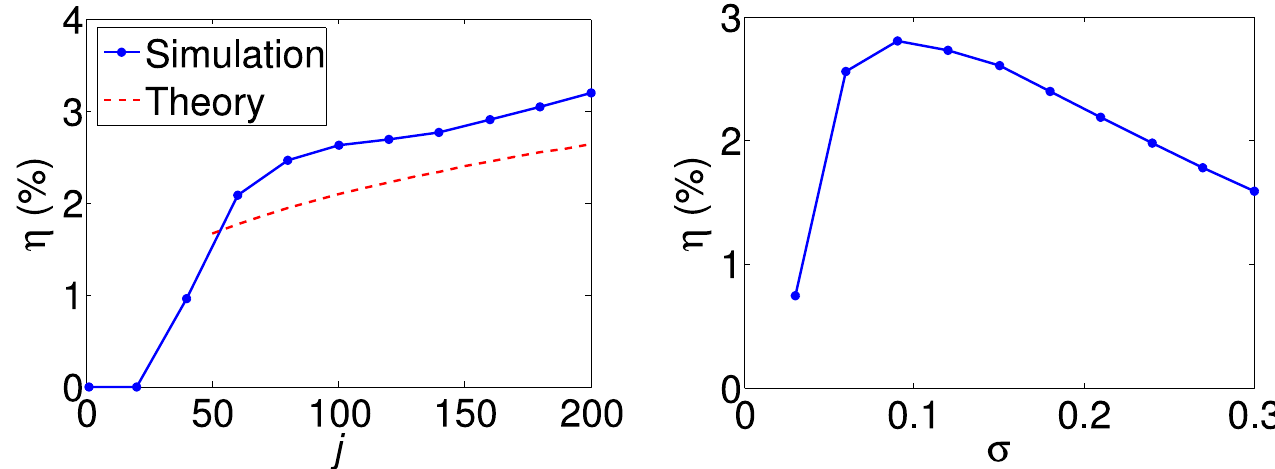
FIG. 9. (Color) Simulation results for extraction (cid:10) versus nor- malized electron beam radius (cid:9) , showing an optimal beam radius at (cid:9) (cid:6) 0 : 1 .